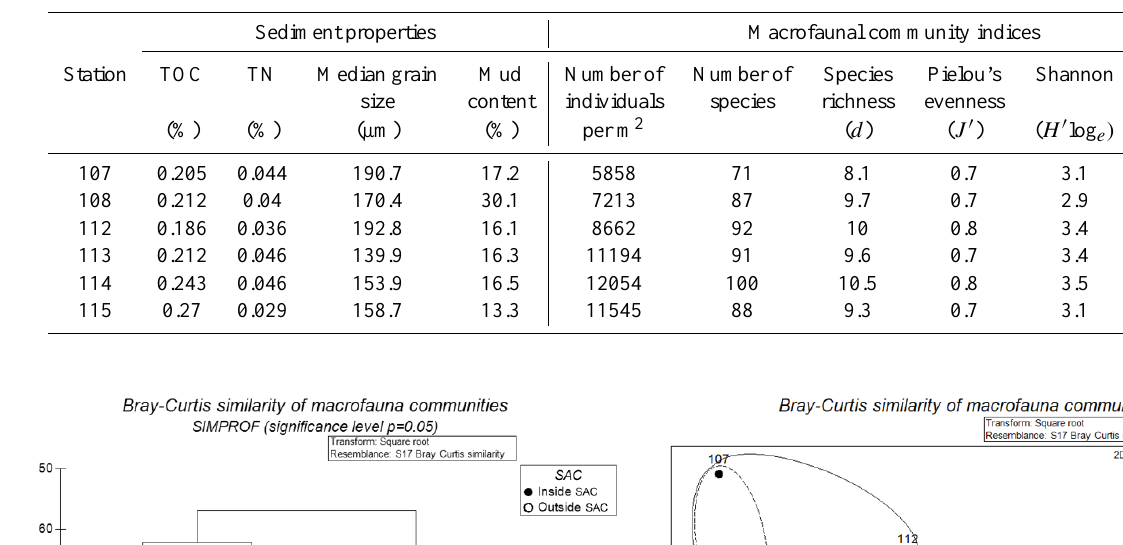
Table 2. Sediment properties (TOC, TN, median grain size and mud content) and macrofaunal community indices (number of individuals, number of species, Margalef’s, Pielou’s, Shannon’s, Simpson’s) at each station collected inside (stations 107, 108 and 112) and outside the SAC (113, 114 and 115).